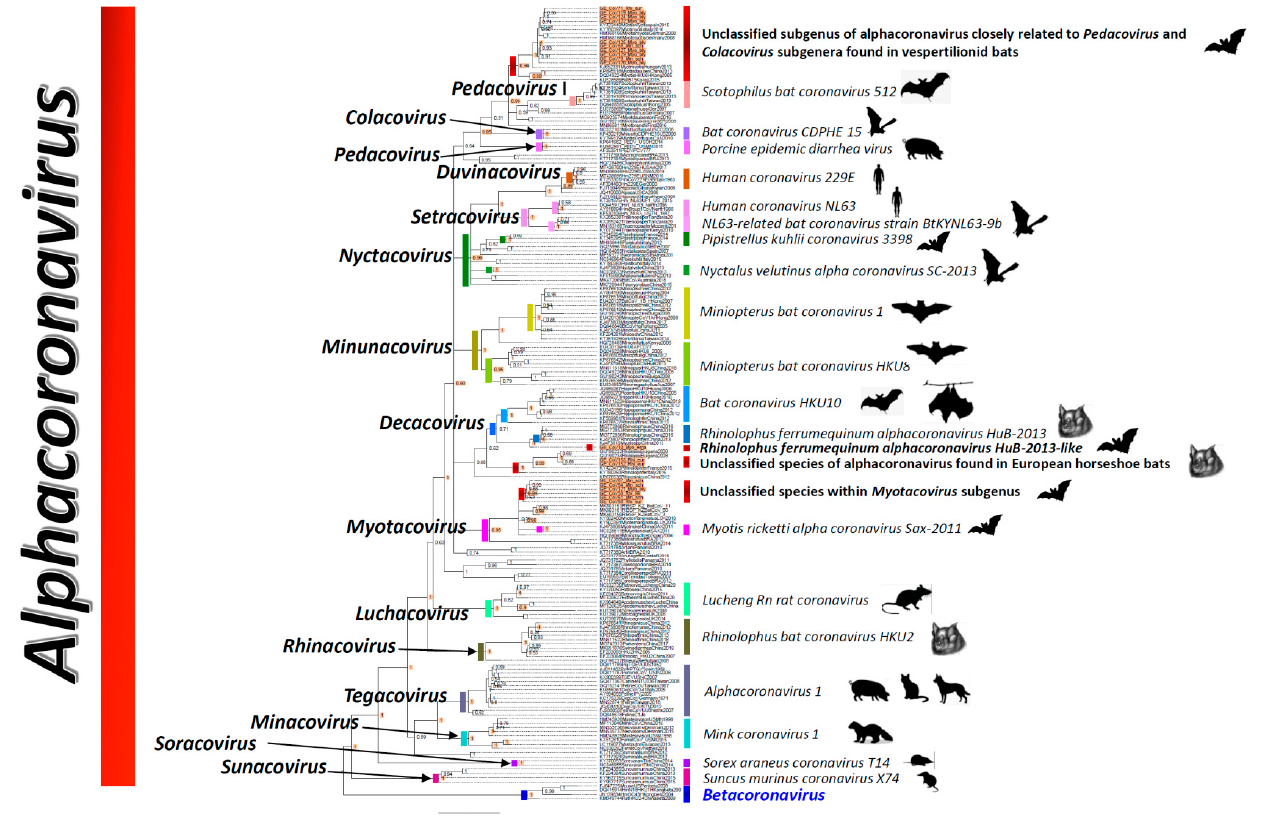
Figure 2. Unrooted Bayesian phylogenetic tree for AlphaCoVs generated with a partial informative 411 bp fragment of the RdRp. Representative BetaCoV taxa were used in the alignment to demonstrate consistent segregation between both genera. Values at nodes represent branch support values expressed as Bayesian posterior probabilities. Scale bar indicates branch lengths. Highlighted nodes are robustly supported with colored bars indicating relevant branches encompassing taxa pertaining to a given subgenus on the left. Bars on the right indicate taxa pertaining to recognized coronavirus species according to the most recent ICTV classification scheme. Taxa highlighted in orange on the right side of the tree indicate coronavirus sequences obtained from Georgian bats. Dark red bars indicate unclassified coronavirus subgenera or species identified herein. Taxa names for all reference sequences in the tree start with their respective GenBank accession number. Animal silhouettes on the extreme right indicate the animal species from which reference sequences were